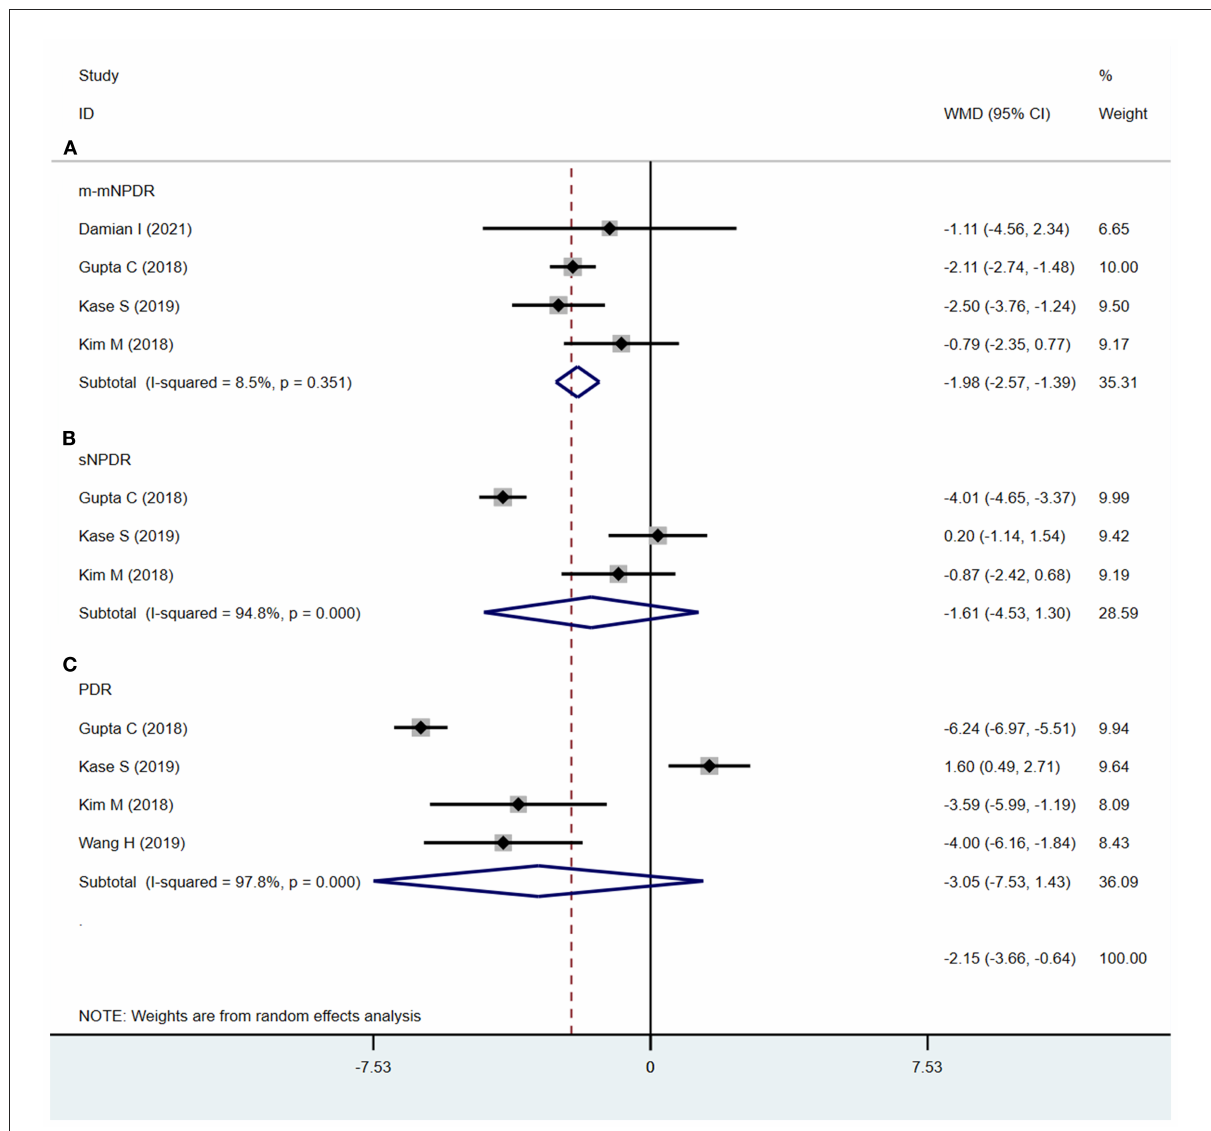
FIGURE6 Choroidal vascularity index (CVI) in patients with NDR and different DR stages. (A) NDR and m-mNPDR. (B) NDR and sNPDR. (C) NDR and